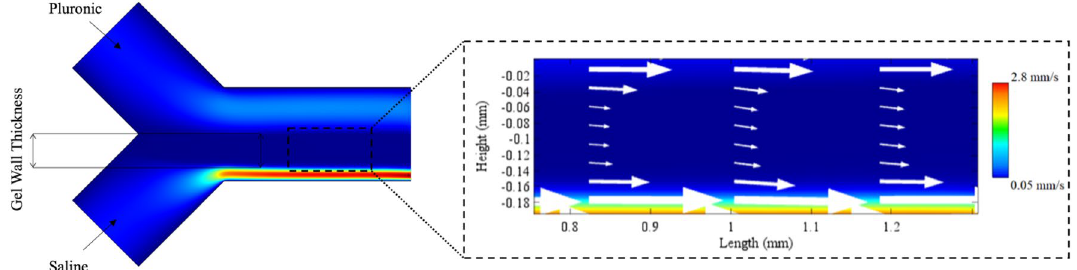
Fig. 9 Velocity vector through a part of microchannel. Volume flow rate of both streams are 8 × 10 –11 m 3 /s. The upper and lower part of the channel shows straight flow directions, while the middle part (gel wall) has a very low velocity with a skewed direction